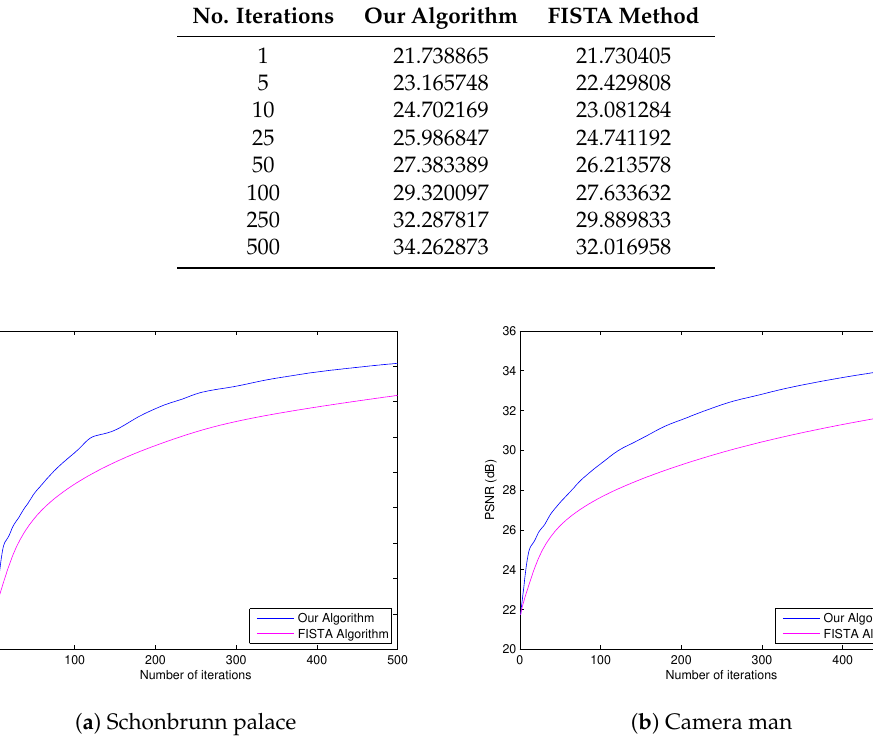
Figure 3. Plotting of the values of